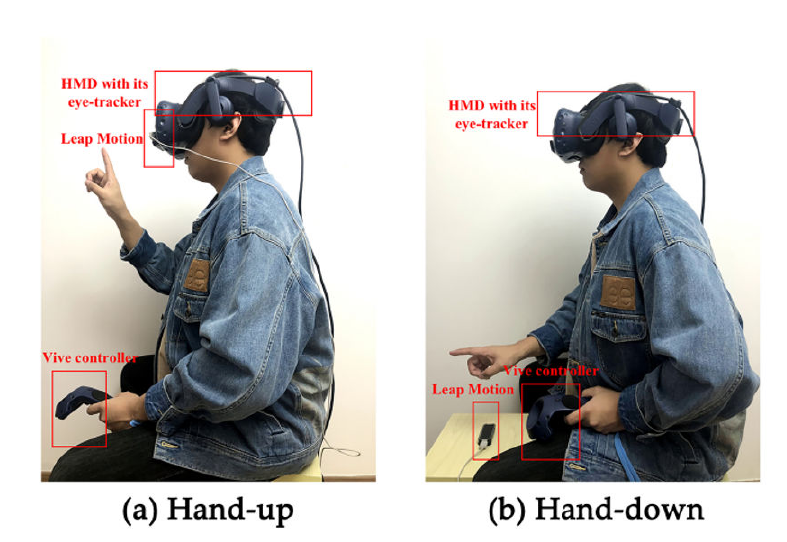
Figure 2. The different input postures. ( a ) Hand-up; ( b )